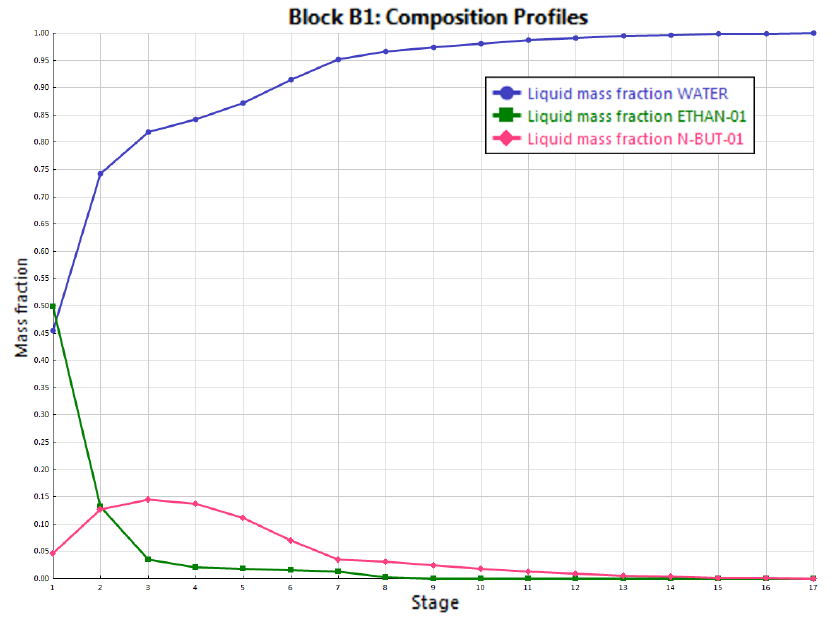
Figure 6. A graph of the column tray compositions as produced by Aspen Plus ®